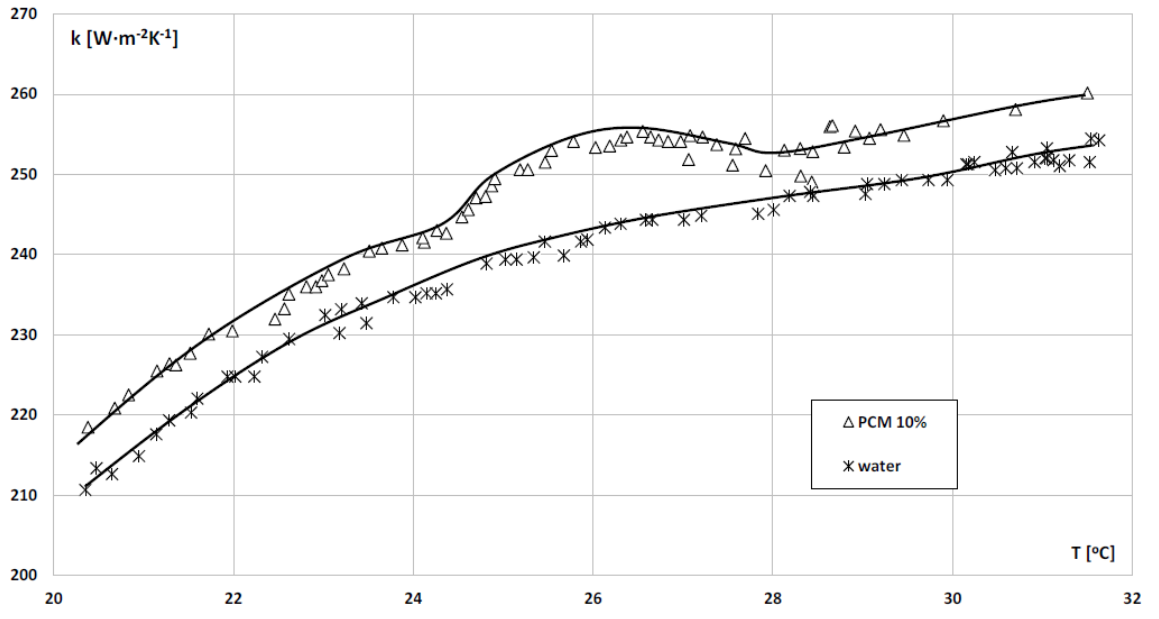
Figure 6. The dependence of the overall heat transfer coefficient k on the coolant temperature at the inlet of the heat exchanger’s cooling section.